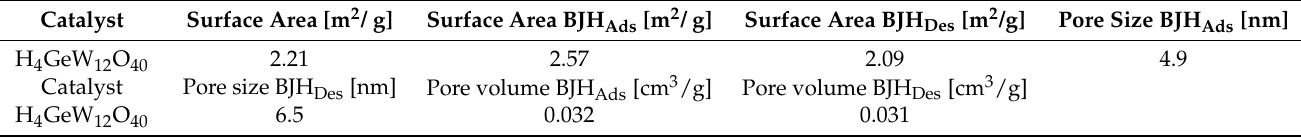
Figure 5. SEM images of H 4 GeW 12 O 40 ( a , b ) and the TEM images of H 4 GeW 12 O 40 ( c , d ). Table 1. BET measurements of the as-synthesized Catalyst.